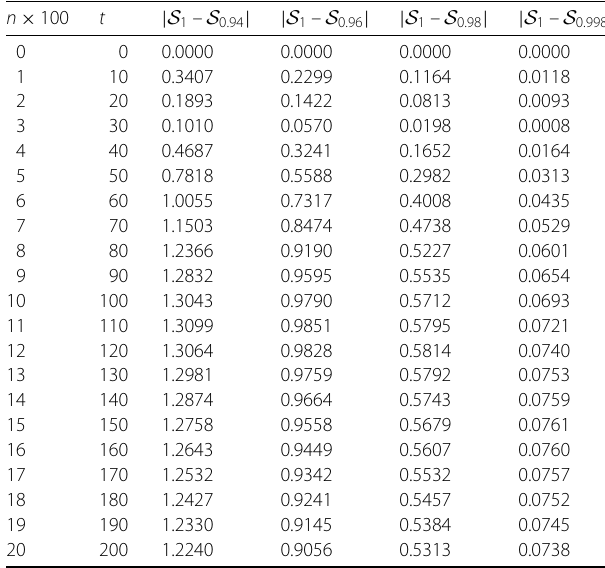
Table 7 The values of | S 1 – S φ | for φ = { 0.94,0.96,0.98,0.998 }